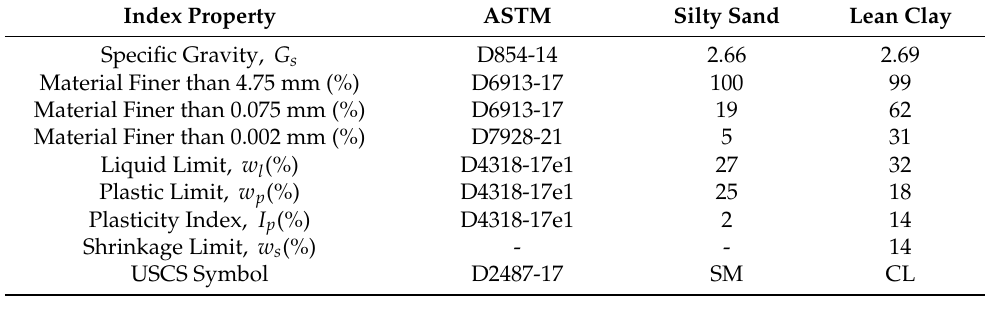
Table 1. Summary of index properties for soil classification.